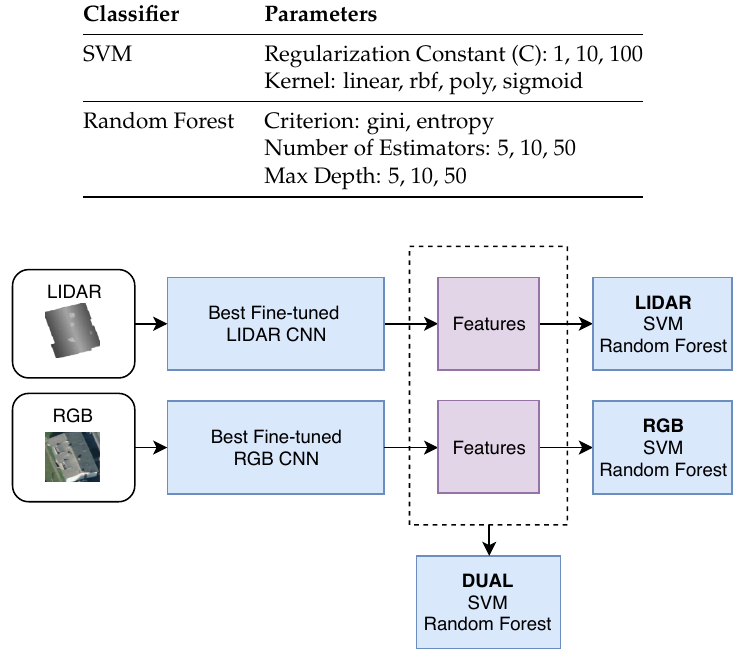
Figure 7. Feature extraction for use in SVM and Random Forest model training. The “dual” model refers to both LiDAR and RGB features being combined as input for model training and